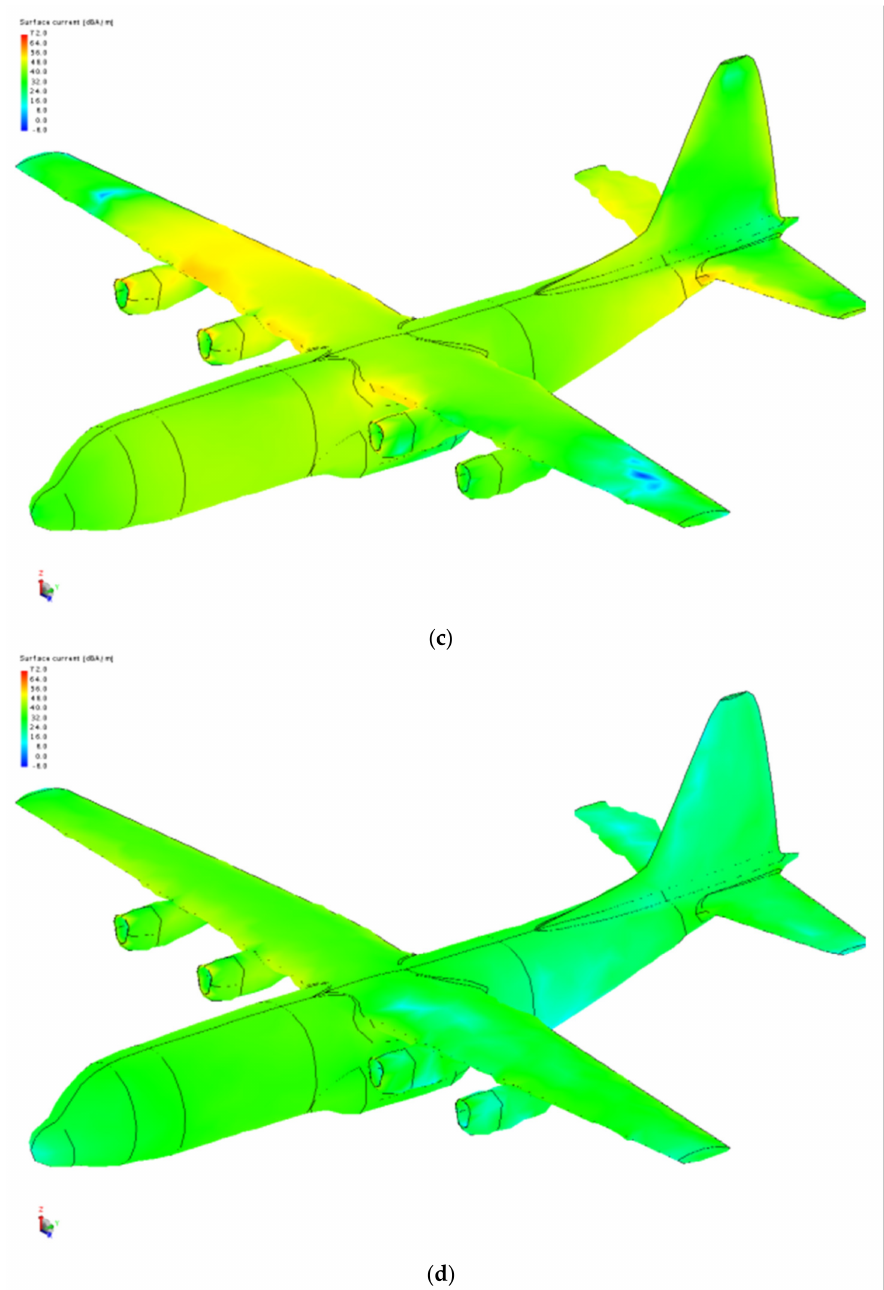
Figure 7. Magnetic field strength distribution H at different time t . ( a ) t = 0 ns, ( b ) t = 10 ns, ( c ) t = 30 ns, ( d ) t = 400